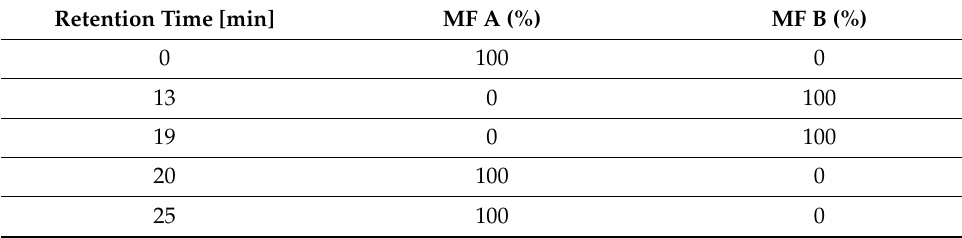
Table 7. Elution